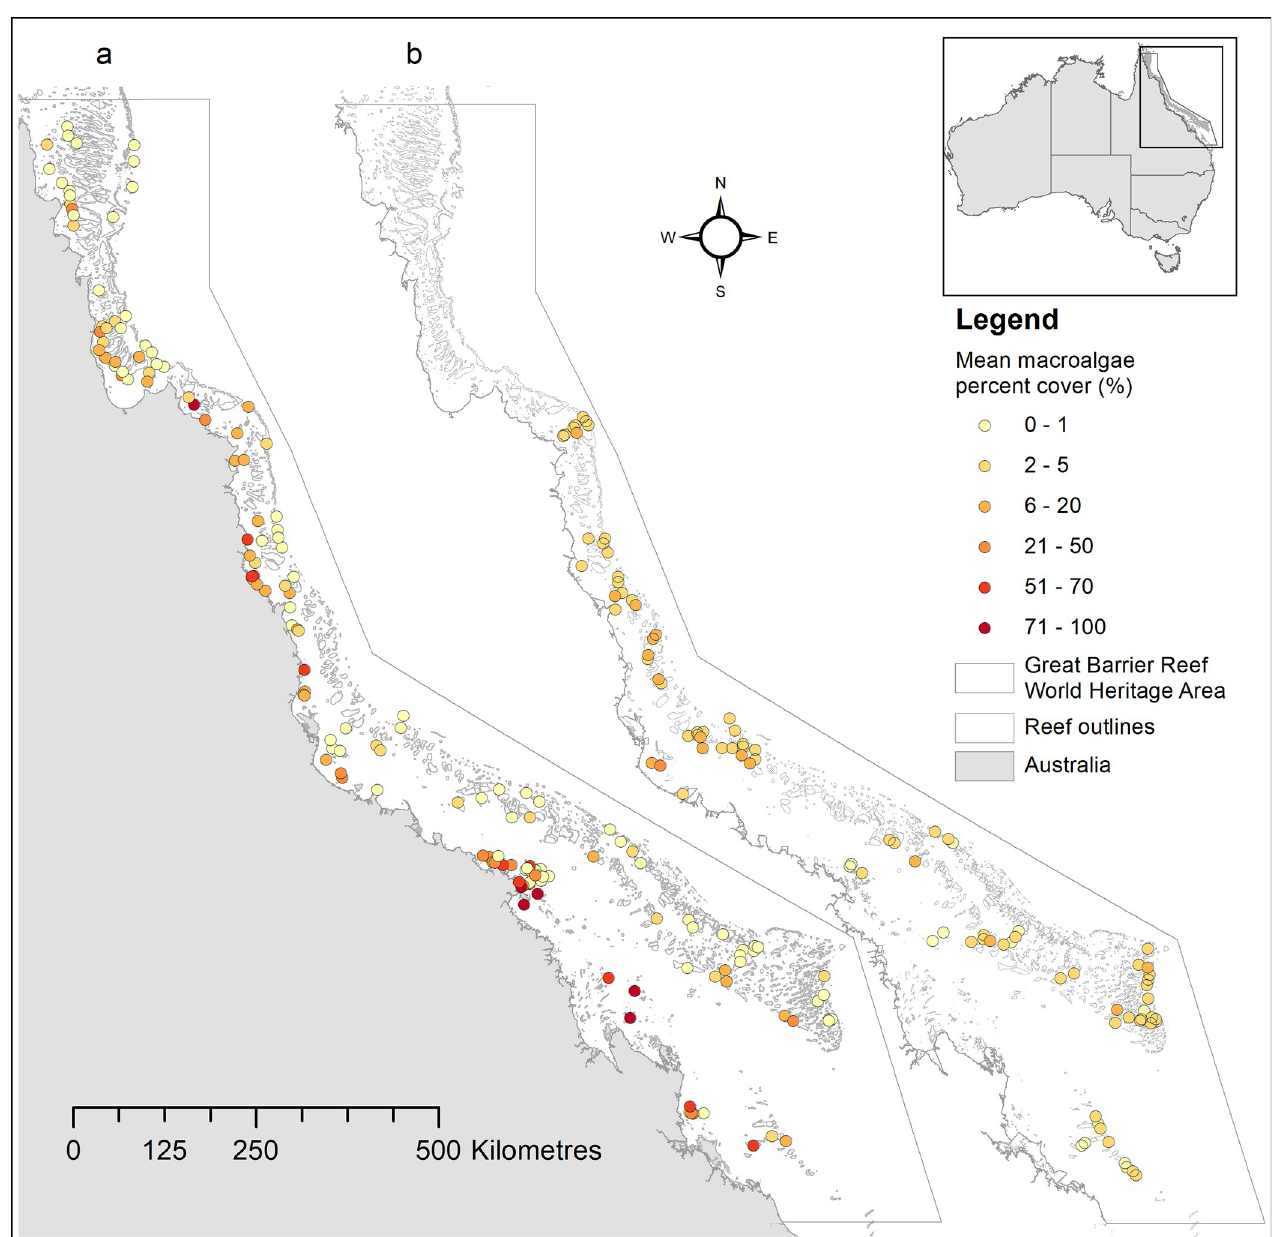
Fig 2. Macroalgal survey locations on the Great Barrier Reef, north-eastern Australia. Colour shading indicates mean macroalgal cover. a. One-off surveys, here shown with values for 2 m depth, b. AIMS Long-Term Monitoring Program at 6–8 m depth. Coastline: Reprinted under a Creative Commons Attribution 4.0 International license, with permission from Australian Bureau of Statistics, original copyright 2011. Reef outlines: Reprinted under a CC BY license with permission from the Great Barrier Reef Marine Park Authority, original copyright 1998. Great Barrier Reef World Heritage Area: Reprinted from Australian Government Department of Climate Change, Energy, the Environment and Water under a CC BY license, with permission from Australian Government Department of Climate Change, Energy, the Environment and Water, original copyright